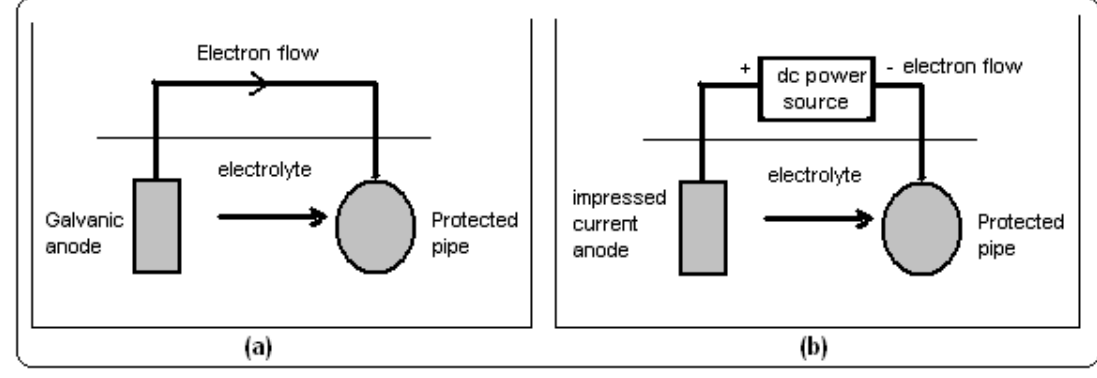
Figure 4. (a) Galvanic system; (b) impressed-current